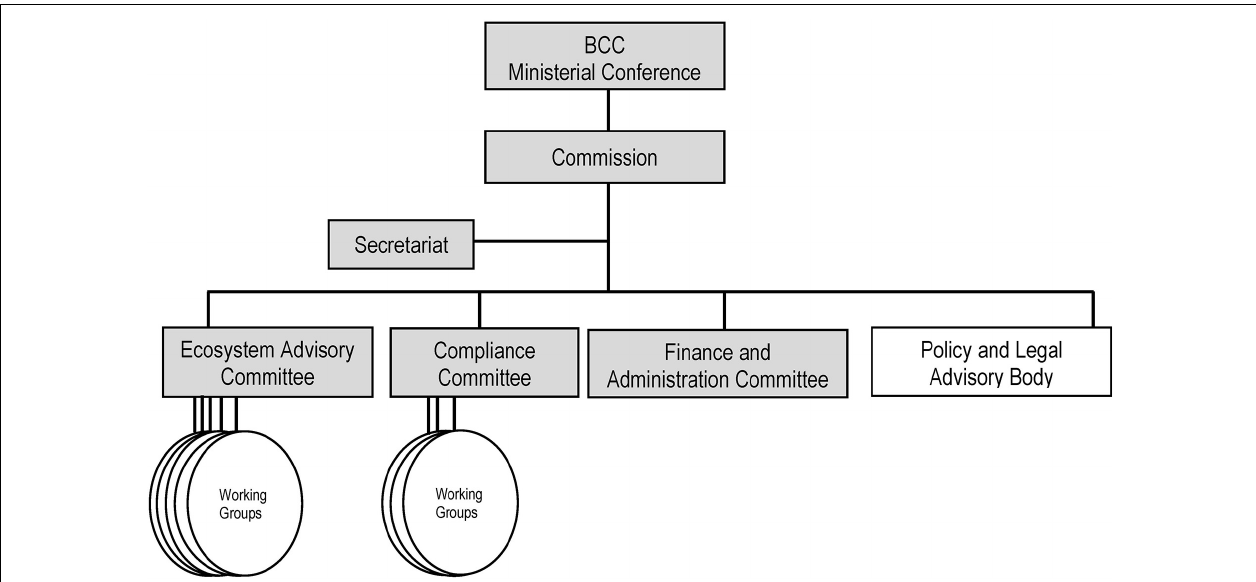
FIGURE 1 | Organigram of Benguela current convention governance and working structures (Note: Shaded structures are created and defined by the Convention. Working groups can be established by any of the committees).